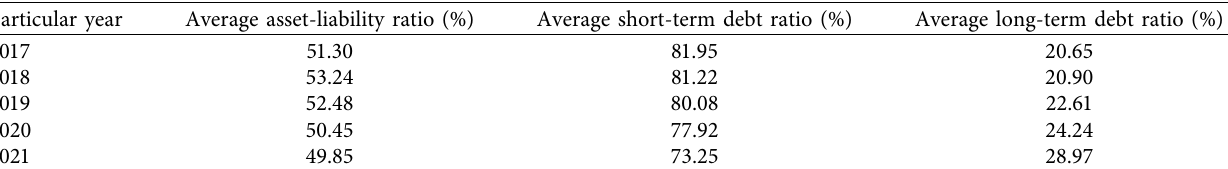
Table 4: Analysis of the overall average debt structure of the collected samples.